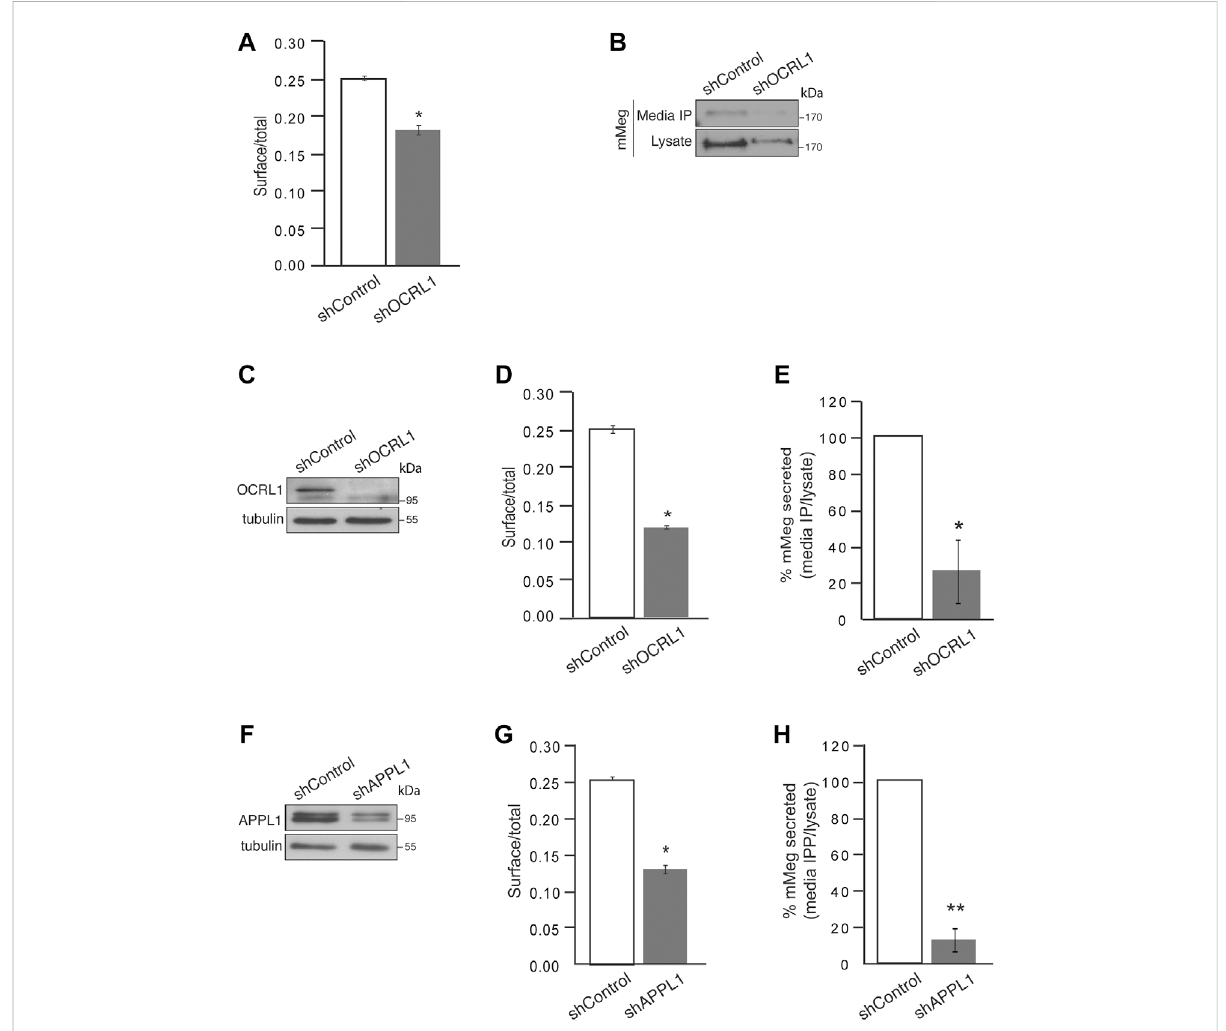
FIGURE 3 Cell surface megalin distribution and extracellular domain release decrease under OCRL1 and APPL1 silencing. (A) mMeg-LLC-PK1 cells, non- permeabilized or permeabilized, control, or OCRL1-silenced were incubated with an anti-HA-488-conjugated antibody and analyzed by fl ow cytometry. The results are plotted as the ratio of expression levels observed in non-permeabilized (surface) versus permeabilized cells (total). Data are expressed as the means ± SEM of N = 3 independent experiments ( t -test, * p < 0.05). (B) Conditioned media of control or OCRL1 silenced mMeg-LLC-PK1 cells were processed by anti-HA immunoprecipitation (Media IP). Samples of IP and cell lysates were analyzed by western blot with ananti-HAantibodytodetectthemegalinectodomain(N-term). (C – H) MDCKcellsstablyexpressingmMeg(mMeg-MDCK)wereinfectedwithnon- target shRNA (shControl), shRNA directed against OCRL1 (shOCRL1) or APPL1 (shAPPL1) lentiviruses. (C) Protein levels of OCRL1 were analyzed in whole-cell lysates of control and OCRL1 silenced cells by western blot. (D) Flow cytometry analyzes mMeg surface localization in control and OCRL1 silenced cells. The plot shows the surface vs. total ratio of expression levels. Data are expressed as the means ± SEM of N = 3 independent experiments ( t -test, * p < 0.05). (E) Analysis of immunoprecipitated conditioned medium and cell lysates of control or OCRL1 silenced cells by westernblotwithananti-HAantibody.TheplotshowsthelevelsofmMegintheimmunoprecipitatedmediacorrectedbytotal.Dataareexpressedas the means ± SEM N = 3 independent experiments ( t -test, * p < 0.05). (F) Protein levels of APPL1 were analyzed in whole-cell lysates of control and APPL1 silenced cells by western blot. (G) Flow cytometryanalyzes mMeg surface localization in control and APPL1 silenced cells. The plot shows the surfacevs.totalratioofexpressionlevels.Dataareexpressedasthemeans±SEMofN=3independentexperiments( t -test,* p < 0.05). (H) Analysisof immunoprecipitated conditioned medium and cell lysates of control or APPL1 silenced cells by western blot with an anti-HA antibody. The plot shows the levels of mMeg in media IP corrected bytotal. Data are expressed as themeans± SEM N = 3independentexperiments ( t -test, ** p <